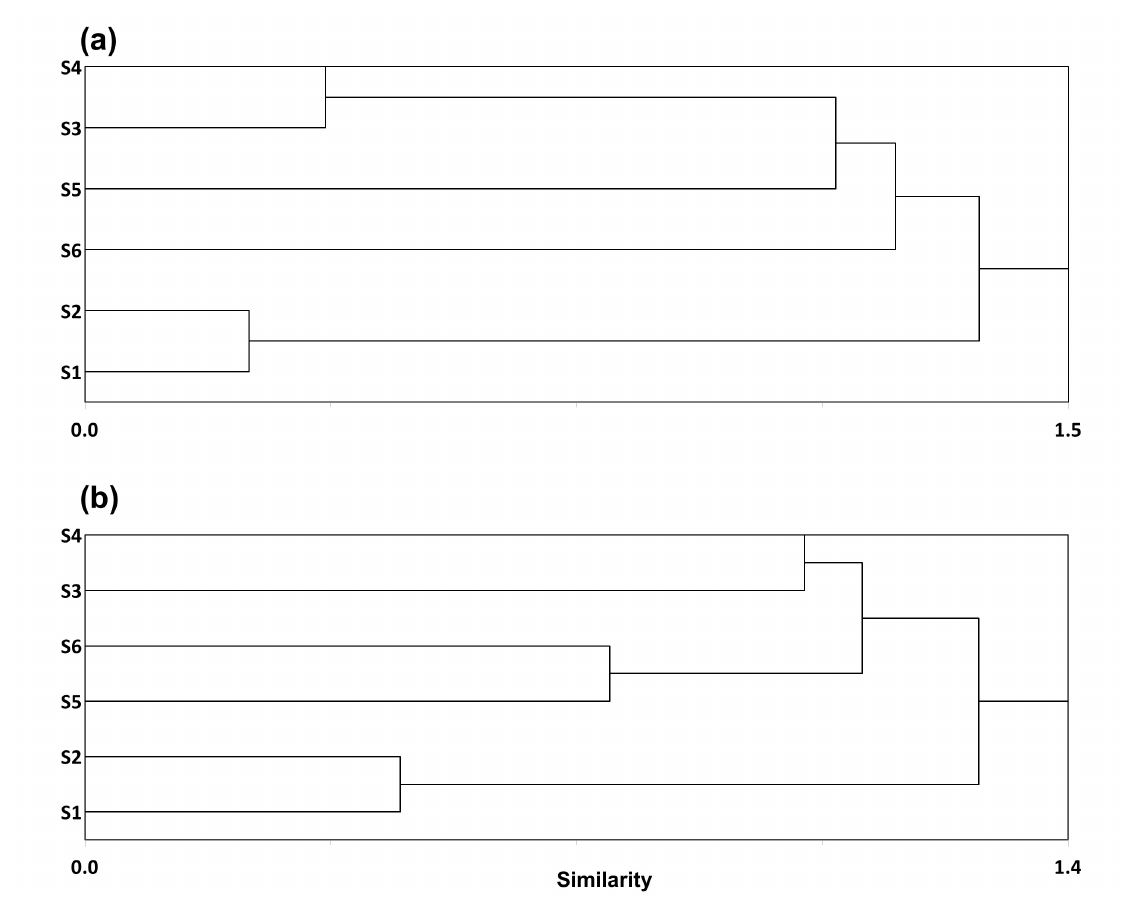
Figure 5. Hierarchical clustering results (dendrogram) of toxic trace metal concentrations in Damietta branch sediments during the summer ( a ) and winter ( b )